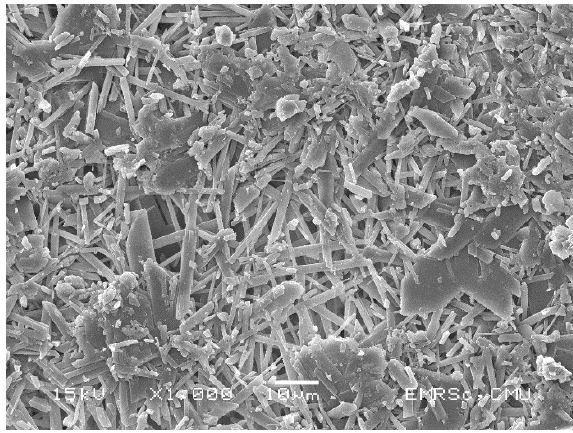
Figure 7. The microstructure of FGD gypsum.